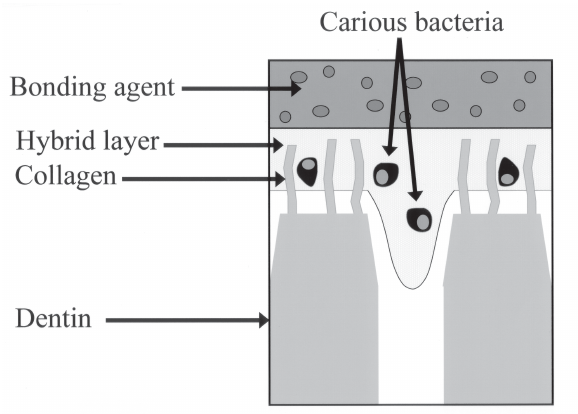
FIGURE 1 - The concept of Modified Sealed Restoration (MSR). Carious bacteria may be embedded with hybrid